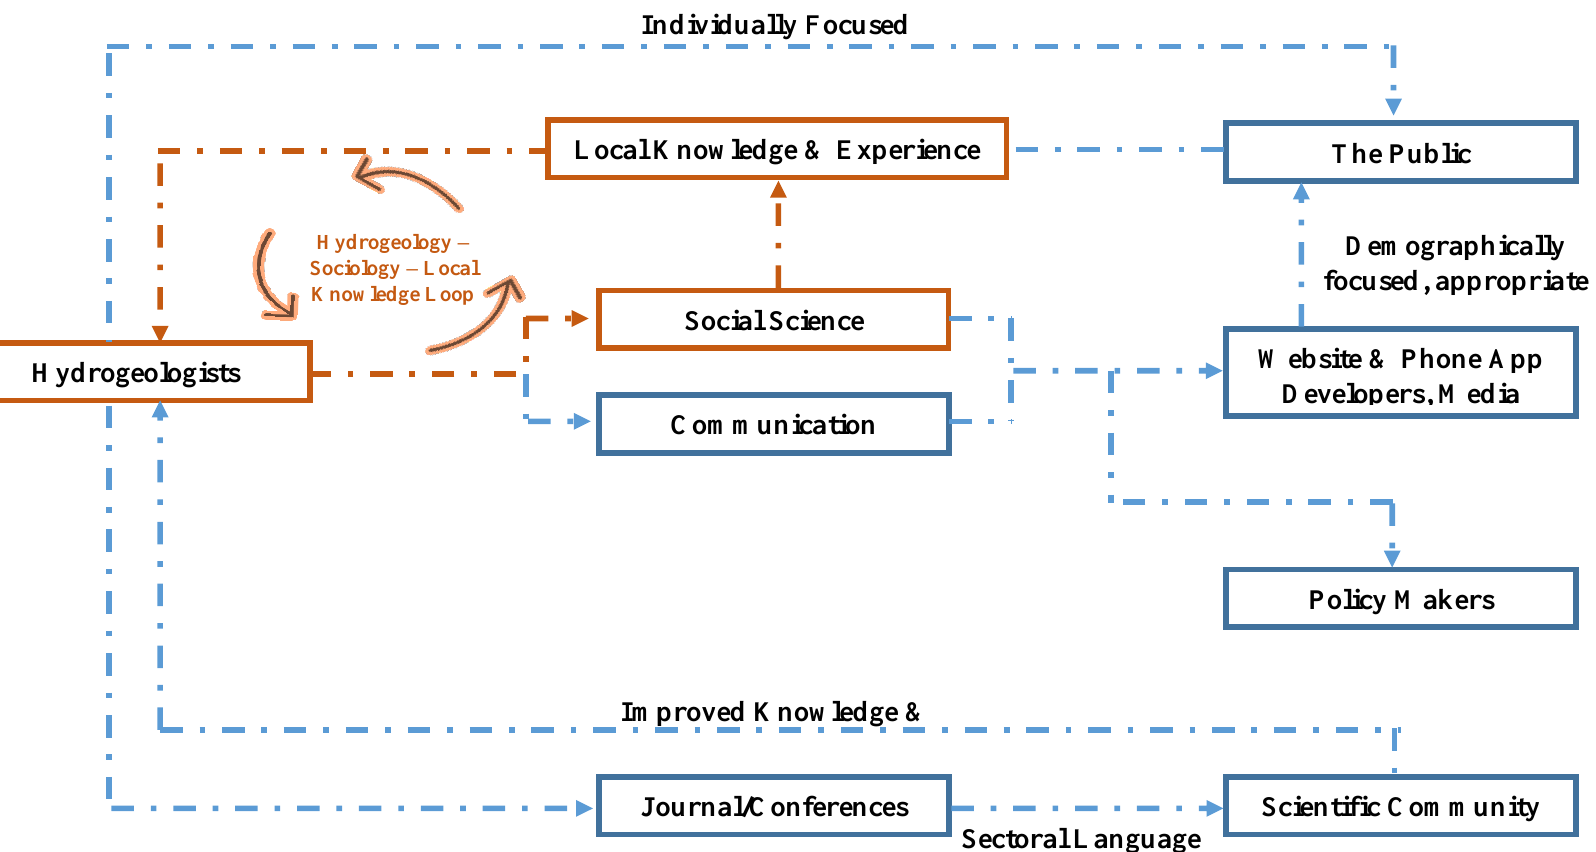
Figure 5. A proposed circular socioeconomy incorporating both “bottom up” (participatory) and “top down” (legislative/policy-driven) elements with hydrogeologists encompassing the communication keystone.